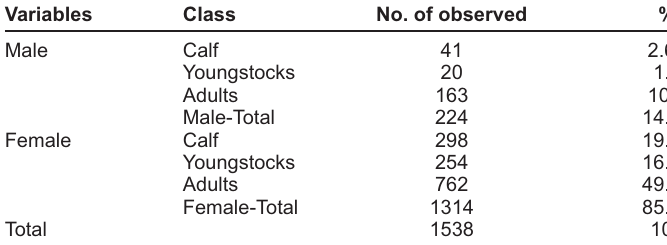
Table-1. Distribution of cattle population maintained by livestock owners